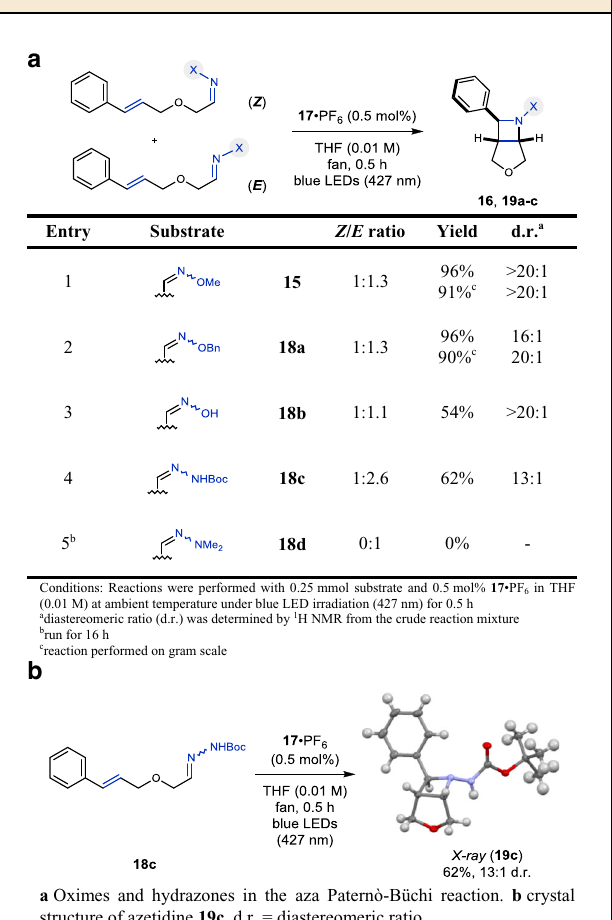
Table 2 Evaluation of oxime and hydrazone substrates